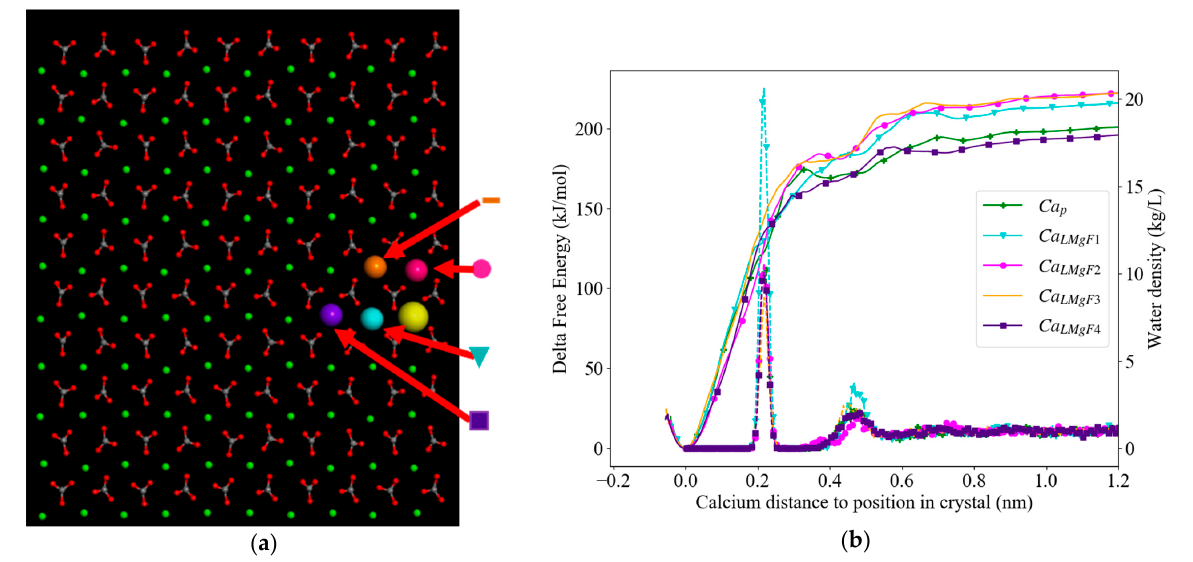
Figure 4. ( a ) Top view of the LMgF (cid:4668) 101(cid:3364)4 (cid:4669) surface with Mg 2+ in yellow, carbonate groups in grey (C) and red (O) and Ca 2+ in small green or colour-coded (cf. Table 3) larger spheres to link them to the free energy profiles in turquoise ( ▼ ), pink ( • ), orange (no marker) and purple ( ). ( b ) Overlay of free energy profile (continuous line, left y -axis) of Ca 2+ extracted from its equilibrium position in the crystal (0.0 nm) with the water z -density (dashed line, right y -axis) along the same axis. The colours are referring to the corresponding Ca 2+ equilibrium position in the left image and Ca 2+ in pure calcite in green (+).